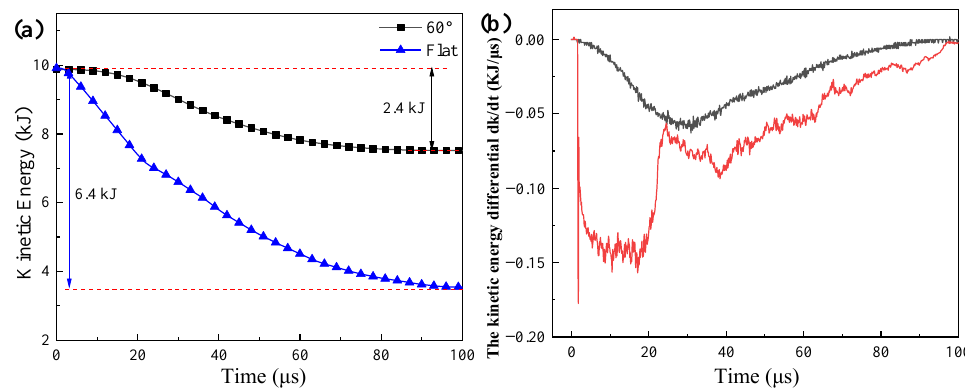
Figure 6. The ballistic responses of the projectile during the penetration process: ( a ) the kinetic energy curves of the projectile; ( b ) the differential curves of kinetic energy, dk/dt .